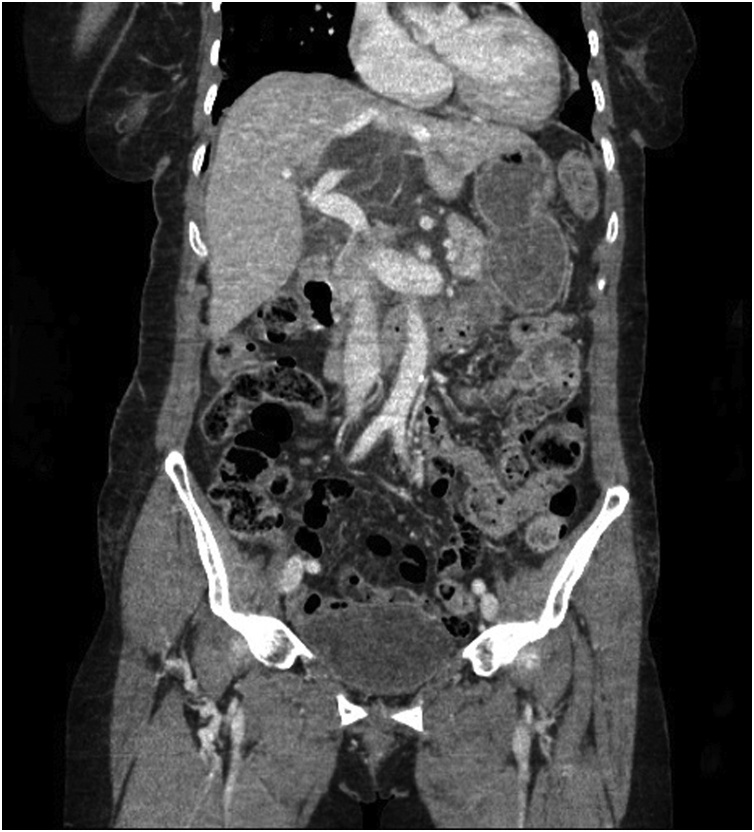
Coronal view on an abdominal computed tomography scan of the patient, showing fluid collection and a cystic lesion around the caudate lobe of the liver.